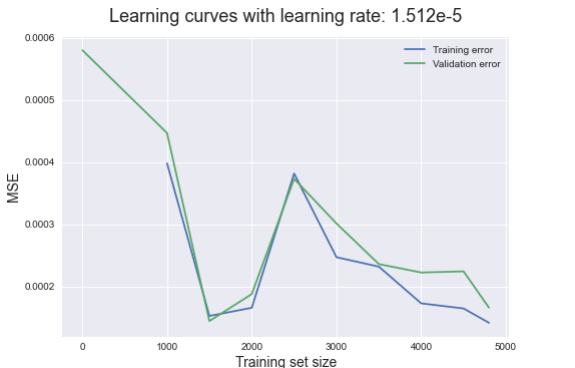
Figure 11. Influence of the training set size in the training and validation phases for the inverse biaxial test model.